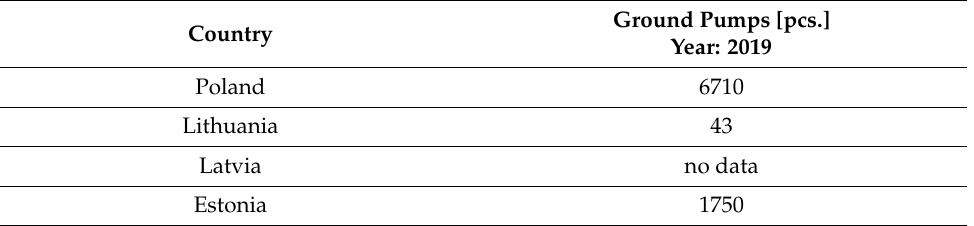
Table 5. Ground source heat pump market in Poland and selected Baltic States in 2019 (sales breakdown/units)